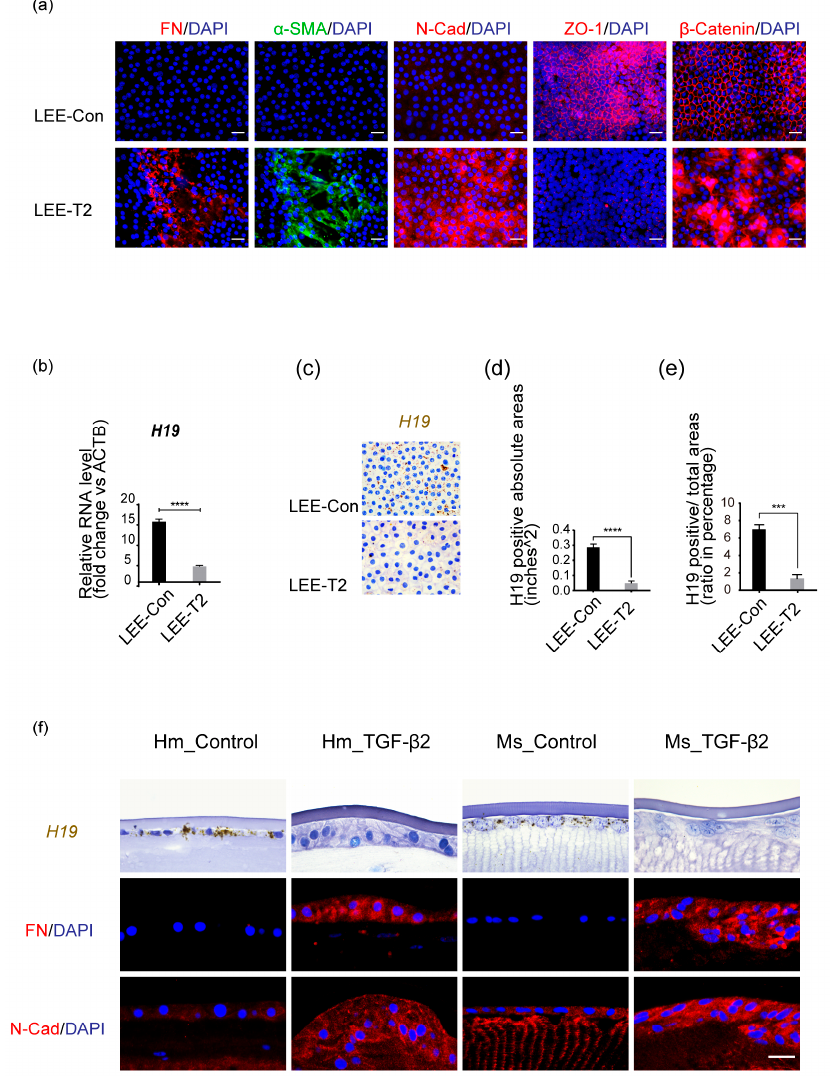
Figure 1. LncRNA H19 was highly expressed in normal lens epithelium while downregulated by exposure to TGF- β 2. ( a ) Immunofluorescent staining of mesenchymal markers (FN, α -SMA, and N-Cad), and epithelial markers (ZO-1, β -catenin), on human lens epithelial explants (LEEs), when exposed to TGF- β 2 (10 ng/mL, 48 h; LEE-T2), in comparison to control group (LEE-Con). Scale bars, 20 µ m. ( b ) RNA analysis of LEEs-Con and LEEs-T2 (age-matched, n = 6) was performed using β -actin as the internal control. ( c ) H19 probes were hybridized in situ. Scale bars, 20 µ m. ( d , e ) Image J was used to quantify the absolute value of H19 positive areas ( d ) and the ratio of H19 positive to total area within each cell ( e ). At least three experiments were repeated, and data were shown as mean ± SD. *** p < 0.001, **** p < 0.0001 vs. LEE-Con. ( f ) RNAscope targeting H19 on the freshly cut sections from human and mouse whole lenses was performed. The lower two panels showed immunostaining of mesenchymal markers FN and N-Cad. Scale bars, 20 μ m.